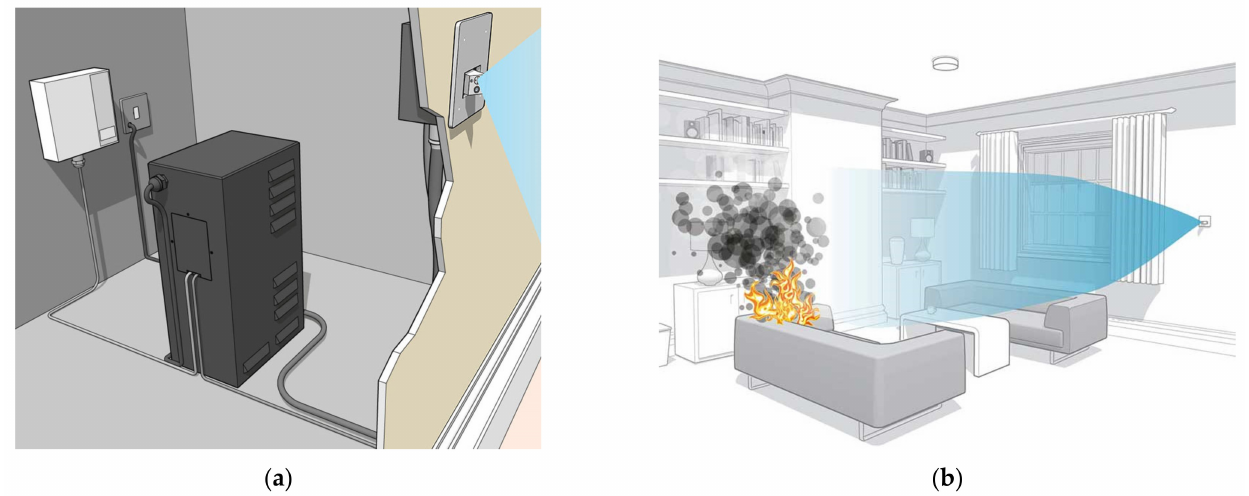
Figure 2. Visualisations of the electronically controlled water mist system: ( a ) controller and pump; and ( b ) nozzle discharging